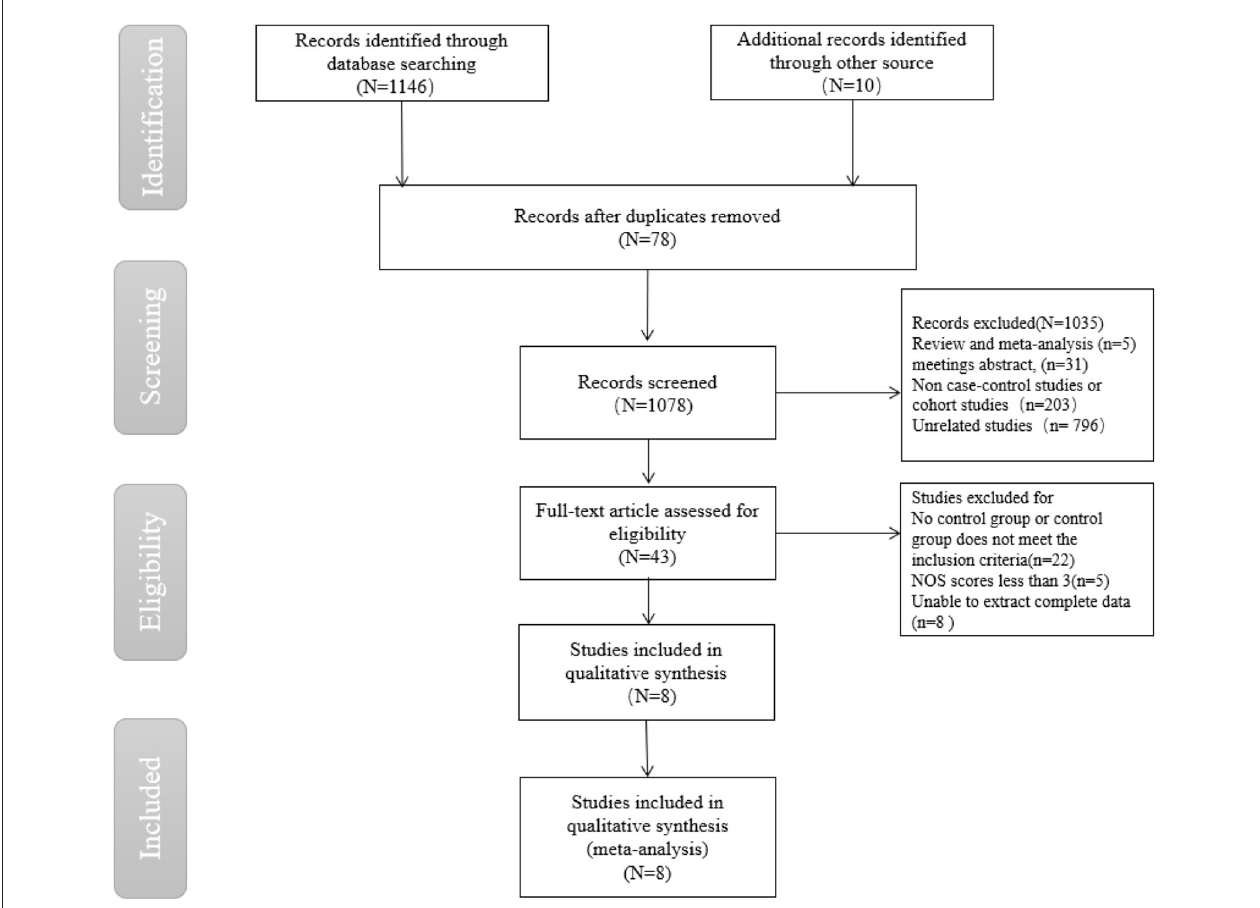
FIGURE 1 | Flow chart of literature screening for meta-analysis on risk factors for acquired Stenotrophomonas maltophilia in intensive care